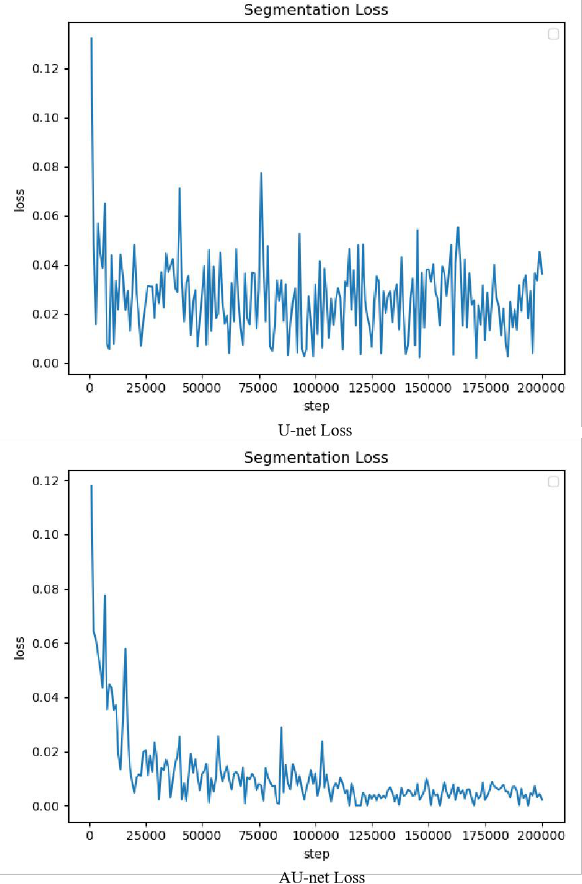
Fig. 6. Loss of network training